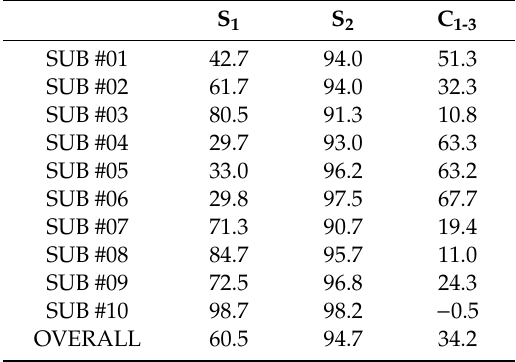
Table 3. The classification accuracy for all gestures with di ff erent synchronous